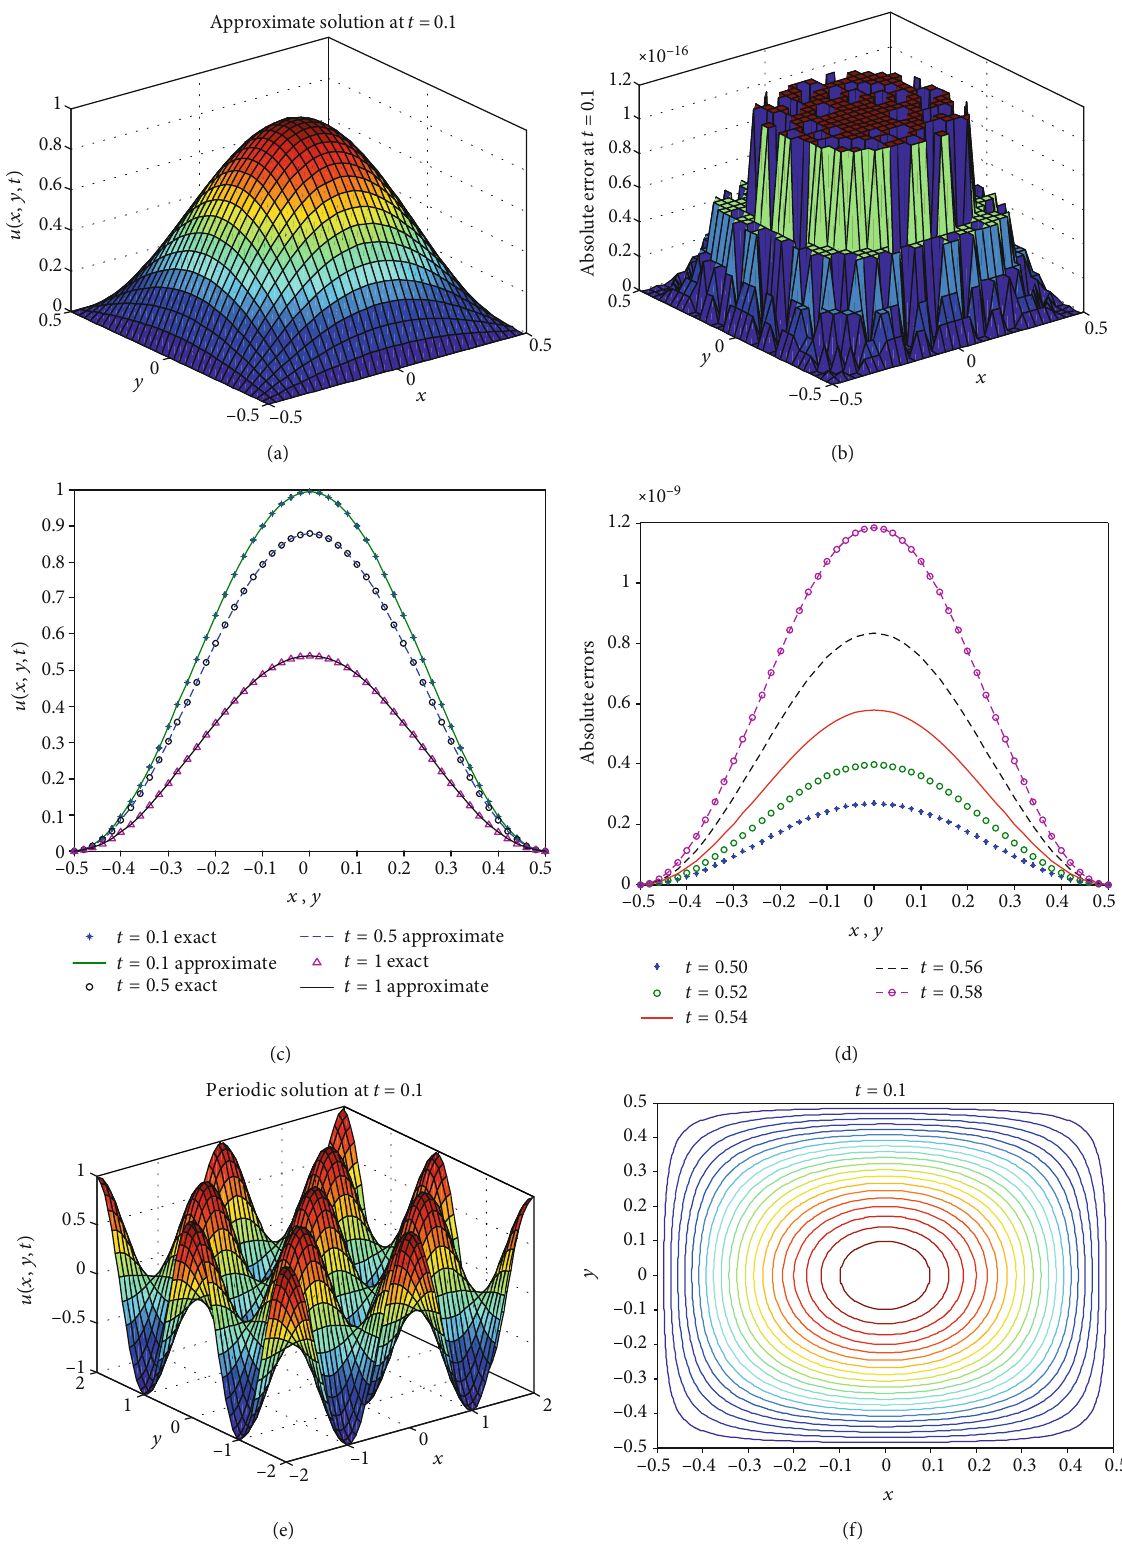
Figure 1: Plots of the solution behavior of Example 1: (a) approximated solutions at time t = 0 : 1 ; (b) absolute errors at time t = 0 : 1 ; (c) comparison of exact and approximated solutions at times t = 0 : 1 , 0.5, 1; (d) comparison of absolute errors for di ff erent values of times t = 0 : 5 , 0.52, 0.54, 0.56, 0.58; (e) the periodic nature of the solution; and (f) the soliton at t = 0 : 1